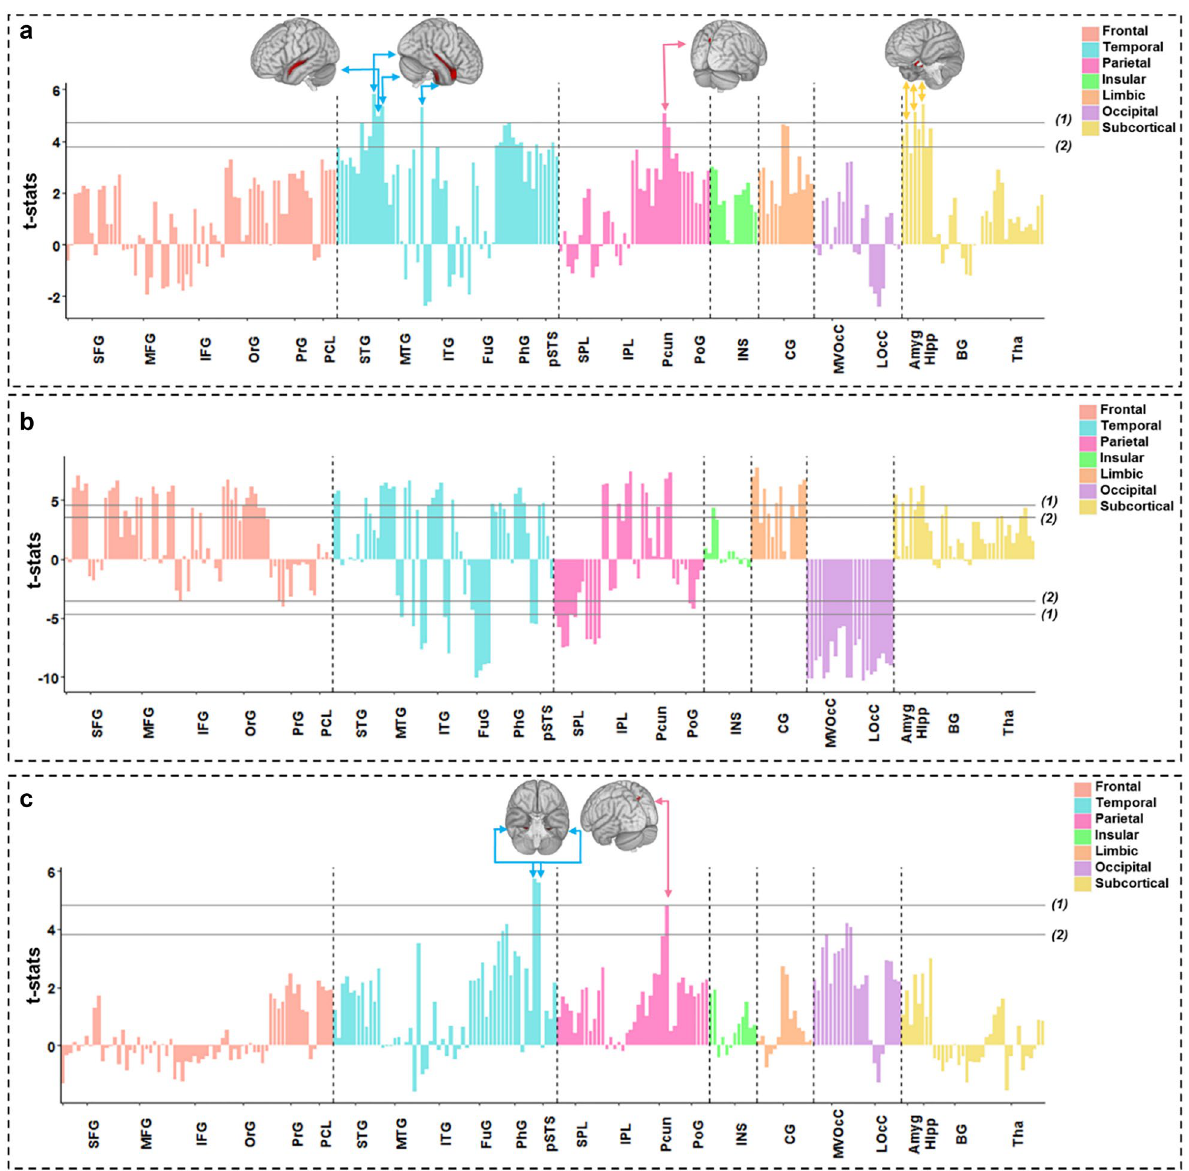
Figure 2. Condition by time interactions in the three linear mixed effects (LME) models. Bars show the coefficient of the condition by time (three windows) interaction term in the three LMEs (with condition: time as a fixed effect and subjects as a random effect) for each Brainnetome (BNA) subregion. 3D brains are those with significant activations in whole brain analyses. ( a ) Coefficient of interaction in the cue-reactivity LME ((Drug Successful NoGo + Drug Successful Go) or (Neutral Successful NoGo + Neutral Successful Go)). ( b ) Coefficient of interaction in the response inhibition LME ((Drug Successful NoGo + Neutral Successful NoGo) or (Drug Successful Go + Neutral Successful Go)). ( c ) Coefficient of interaction in the methamphetamine-related response inhibition LME ((Drug Successful NoGo-Drug Successful Go) or (Neutral Successful NoGo-Neutral Successful Go)). (1) FDR corrected p -value < 0.001. (2) FDR corrected p -value < 0.05. LMEs were implemented and visualized using R software version 3.6.2 (https:// www.r- proje ct. org/). 3D brains were visualized using FSLeyes, the FSL image viewer (https:// open. win. ox. ac. uk/ pages/ fsl/ fsley es/ fsley es/ userd oc/ insta ll. html). SFG superior frontal gyrus, MFG middle frontal gyrus, IFG inferior frontal gyrus, OrG orbital gyrus, PrG precentral gyrus, PCL paracentral lobule, STG superior temporal Gyrus, MTG middle temporal gyrus, ITG inferior temporal gyrus, FuG fusiform gyrus, PhG parahippocampal gyrus, pSTS posterior superior temporal sulcus, SPL superior parietal lobule, IPL inferior parietal lobule, Pcun precuneus, PoG postcentral gyrus, INS insular gyrus, CG cingulate gyrus, MVOcC medioventral occipital cortex, LOcC lateral occipital cortex, Amyg amygdala, Hipp hippocampus, BG basal ganglia, Tha